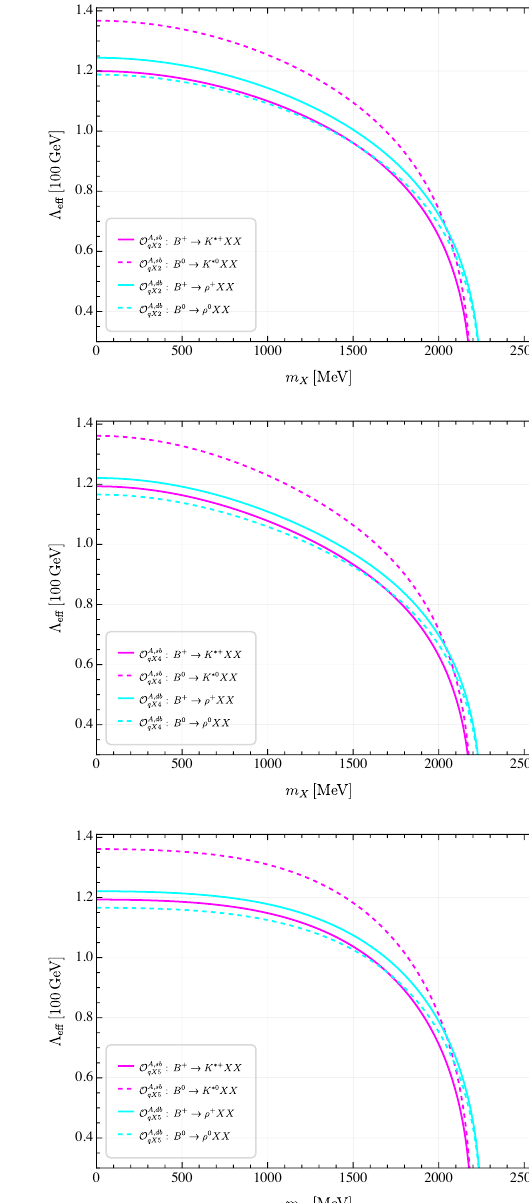
Figure 6 . Constraints on the effective new physics scale for the 6 dim-6 operators O V,A function of the DM mass m from B → K ( π ) /E